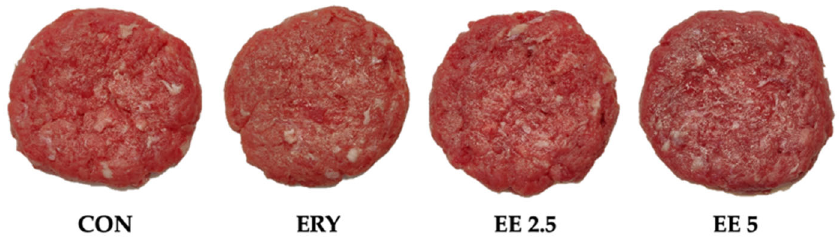
Figure 1 . Visual aspect of the beef burgers formulated after the preparation (T0) and considering the four treatments, namely CON, ERY, EE 2.5, and EE